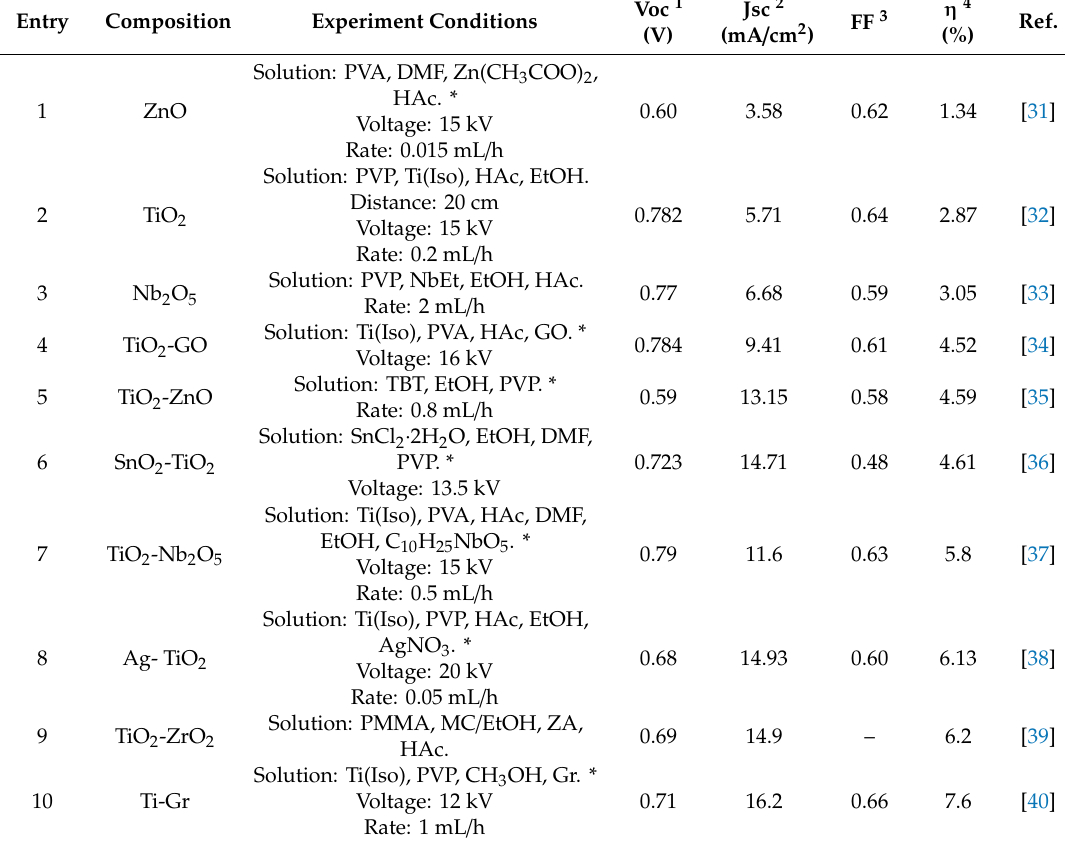
Table 1. Comparison of the characteristics of electrospun nanofibers for